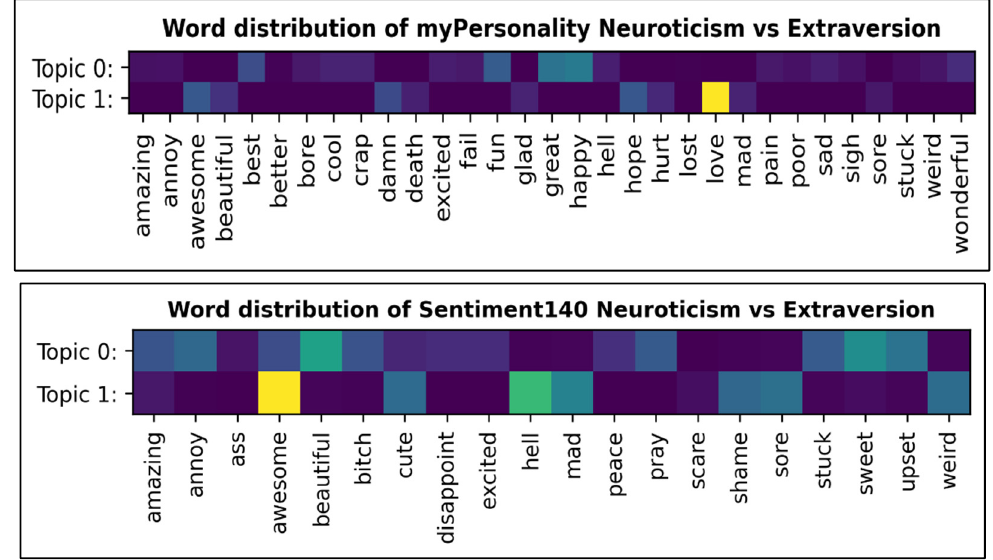
Figure 3. Word distribution of Neuroticism and Extraversion for myPersonality and Sentiment140.